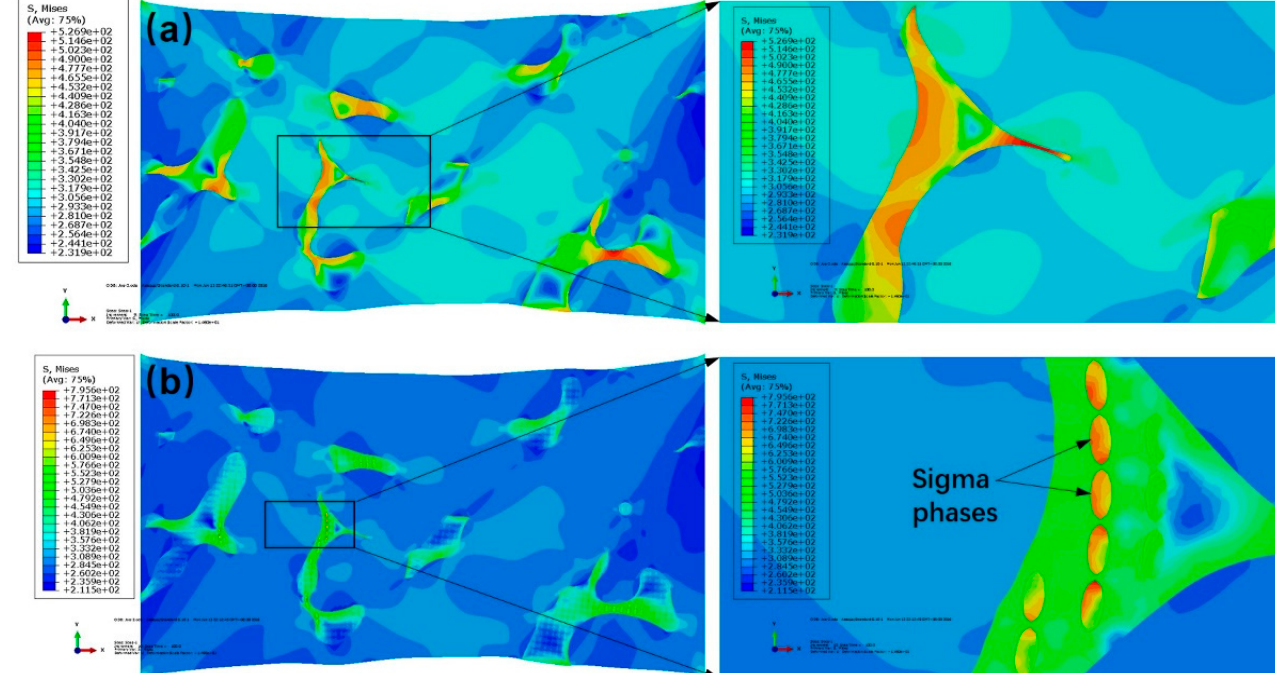
Figure 13. Calculated results of stress distribution in Z3CN20.09M specimens without ( a ) and with ( b ) sigma phases under tensile tests. ( b ) sigma phases under tensile